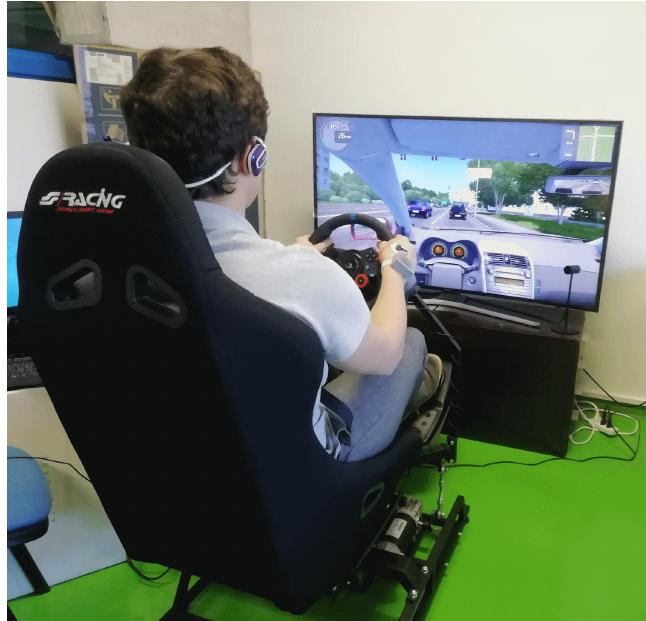
Figure 9. The driving simulator available in our laboratory at the University of